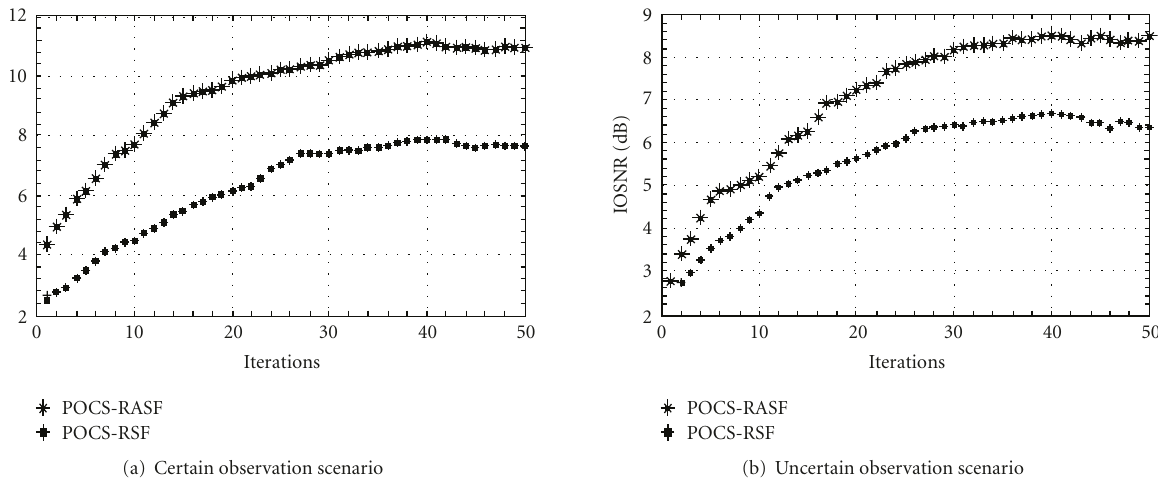
Figure 13: Convergence curves of the iterative POCS-RSF and POCS-RASF algorithms.